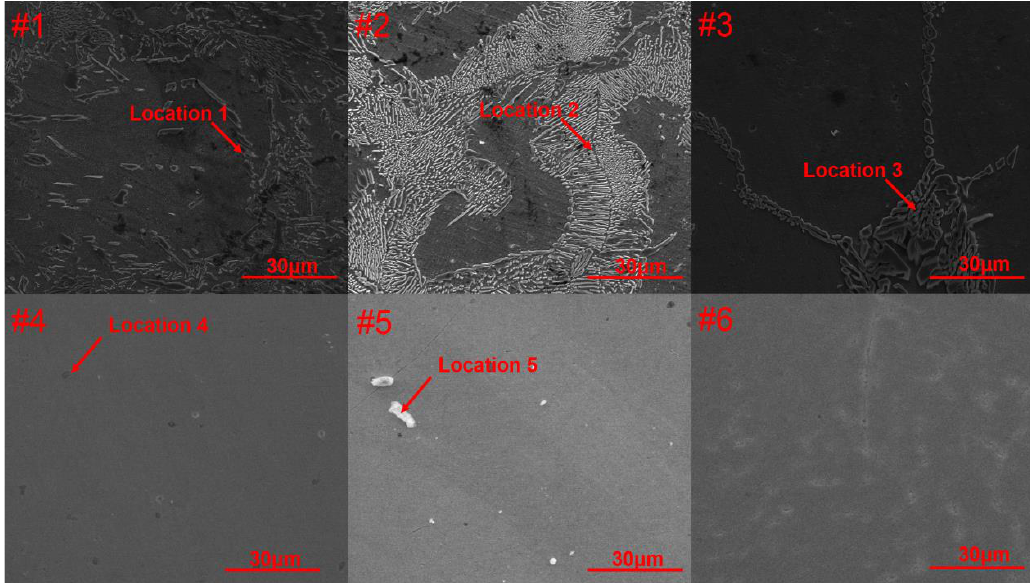
Figure 2. SEM image of alloys grain. A large number of FeCr phases accumulated at the grain boundaries in #1 alloy. In #2 alloy, FeCr phase nucleated on the carbide. There was distribution of FeCr along the grain boundary in 3# alloy. (Ni Fe)Al phase was precipitated in #4 and #5 alloys, which played the role of precipitation strengthening. Table 2. Chemical compositions of the respective locations shown in Figure 2. There were both